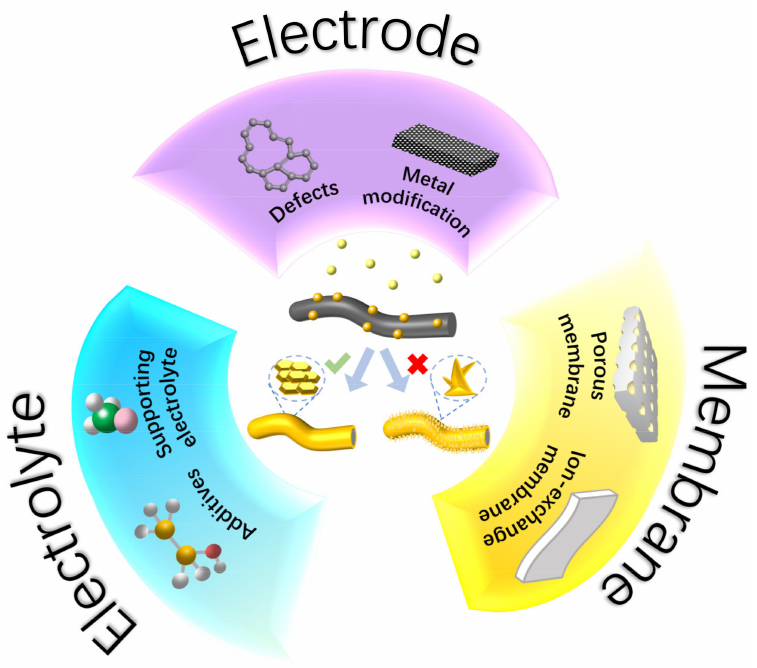
Figure 2. Electrode, electrolyte, and membrane materials for a dendrite-free